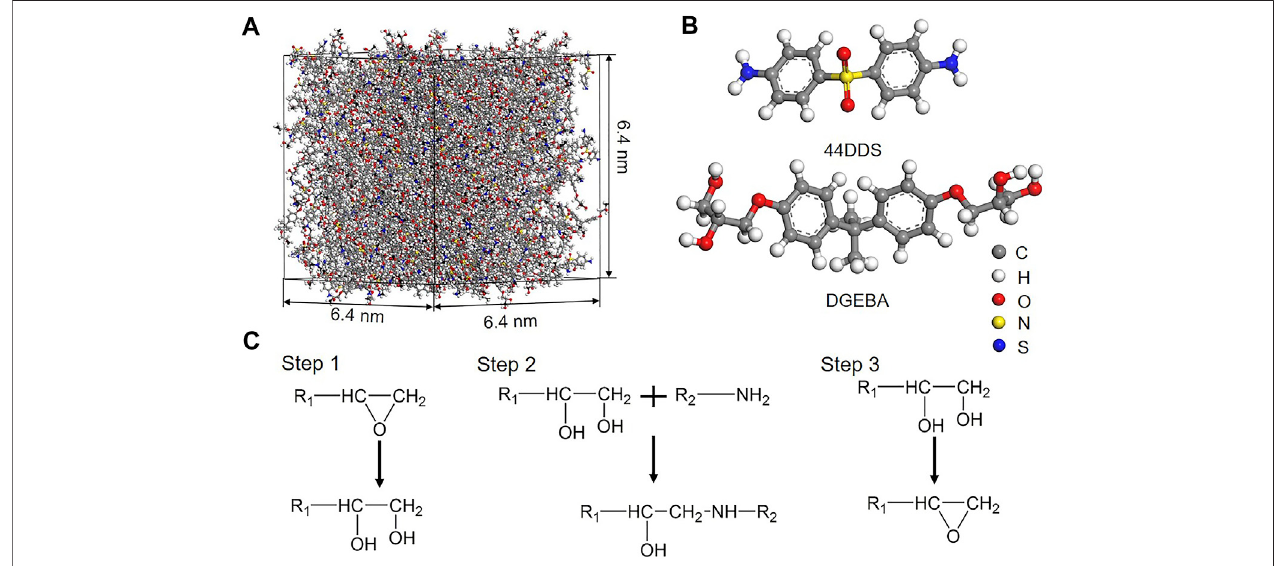
FIGURE1|(A) Crosslinkedepoxyresinwithasizeof6.4 × 6.4 × 6.4 nm; (B) molecularstructuresofdiglycidyletherofbisphenolA(DGEBA)andcuringagent4,4 ′ - diaminodiphenyl sulphone (44DDS); (C) steps for crosslinking where epoxide groups in DGEBA are activated and react with amine groups in 44DDS.